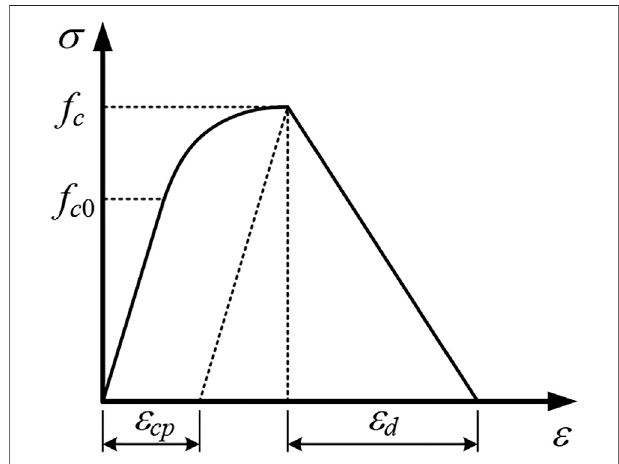
FIGURE 11 | Constitutive model of polymer matrix in